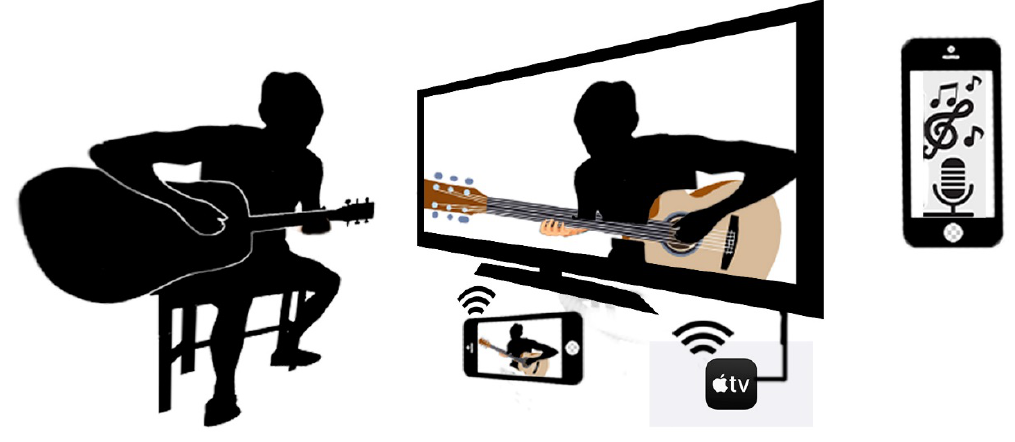
Figure 3. Scenario demonstrating how learners use the mobile augmented reality (AR) app.